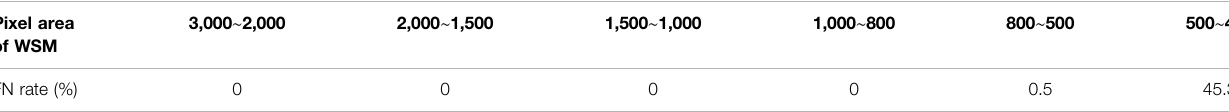
TABLE 1 | FN rate analysis for WSMs.